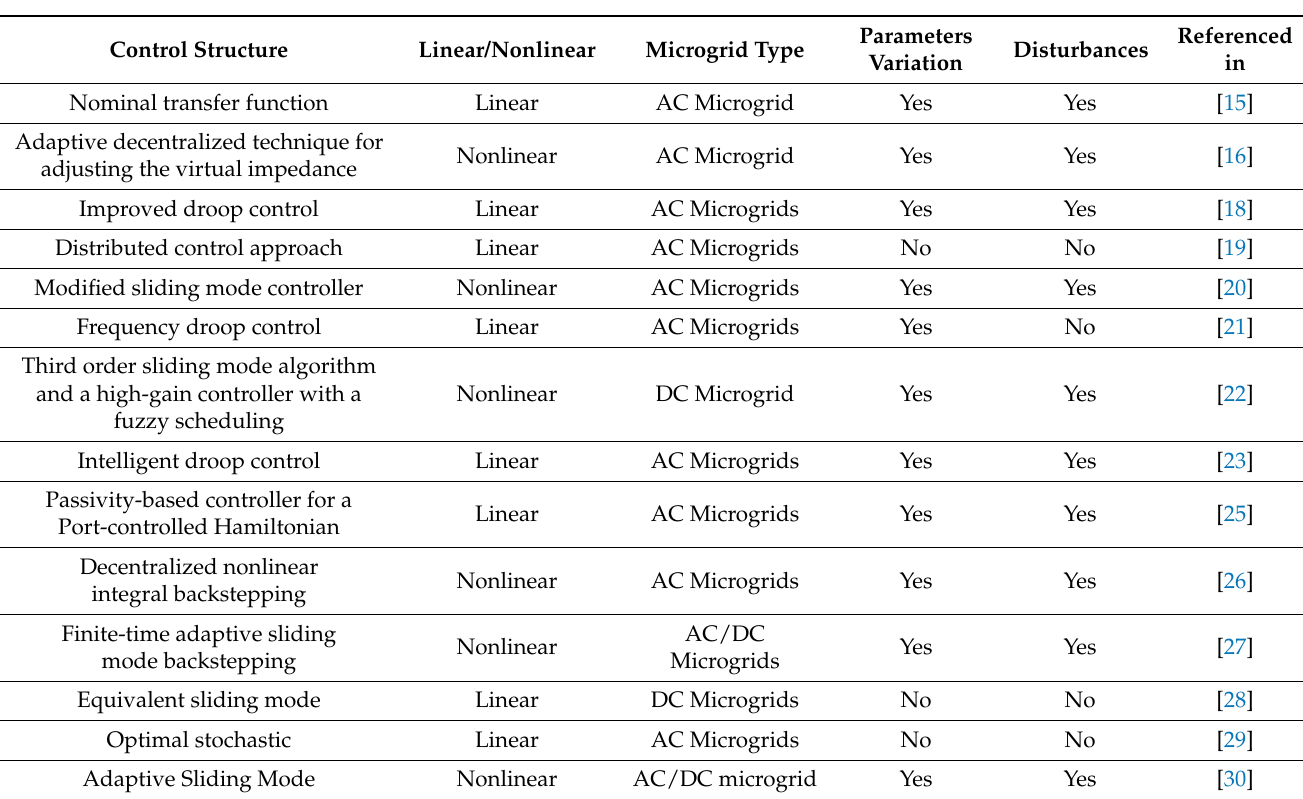
Table 1. Summary of different control methods for MGs in the literature focused on the considered